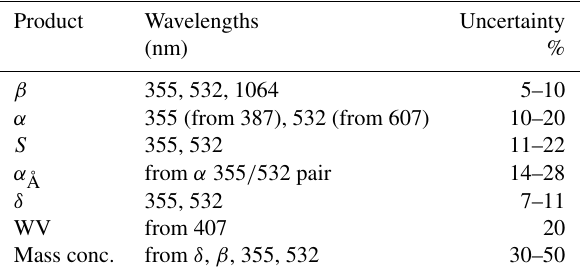
Table 1. Products of the Polly XT lidar and their relative uncertain- ties. β : particle backscatter coefficient, α : particle extinction coef- ficient, S : lidar ratio, α : extinction-related Ångström exponent, δ : Å particle linear depolarization ratio, WV: water vapor, and dust and non-dust mass